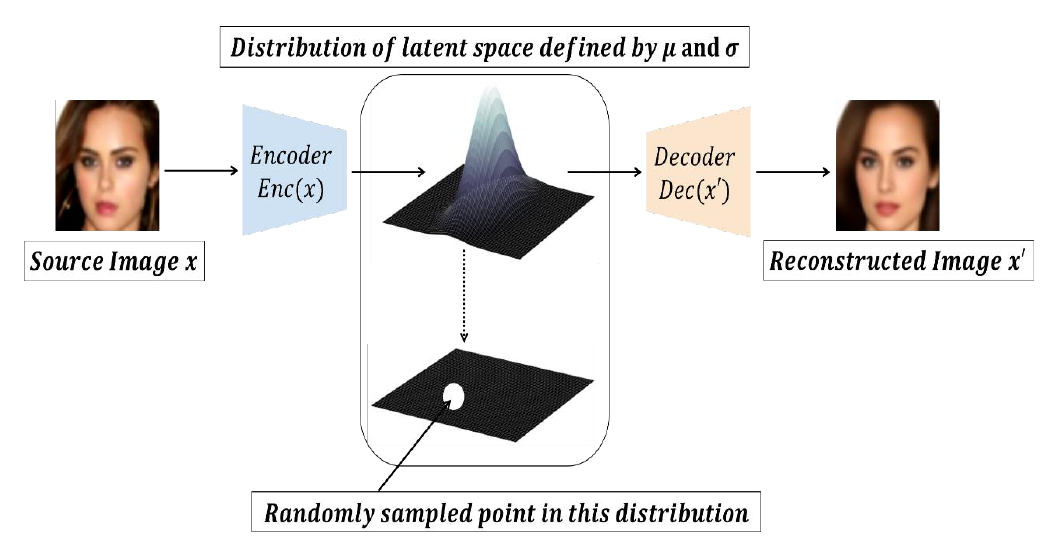
Figure 8. VAE (Variational AutoEncoder).